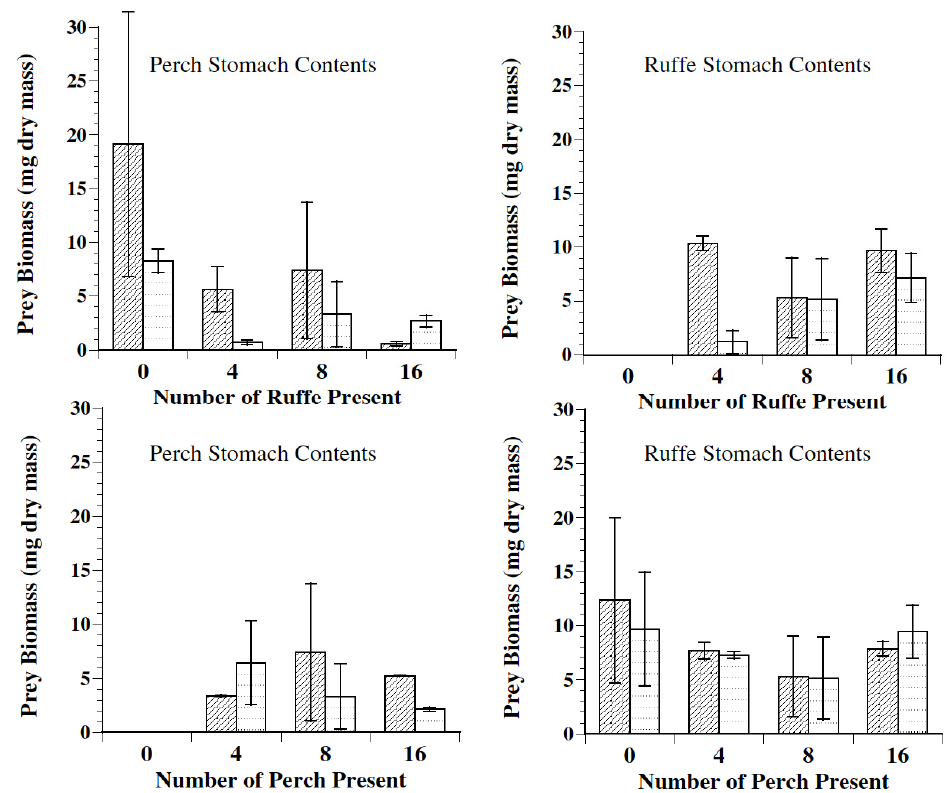
Figure 6. Estimated stomach content mass of yellow perch with increasing ruffe density ( top left ), ruffe with increasing ruffe density ( top right ), ruffe with increasing yellow perch density ( lower right ), and yellow perch with increasing yellow perch density ( lower left ) (experiment 2, 11 August– 15 September). Stomach content mass is shown after 2.5 weeks (cross-hatching) and 5 weeks (horizontal stripes). Treatment means are shown plus or minus one standard error. There are two replicates of each treatment. There was a significant effect of ruffe on perch stomach content mass ( p = 0.014), but no effect of ruffe on ruffe stomach content mass or of perch on either ruffe or perch stomach content mass (all p >0.1).